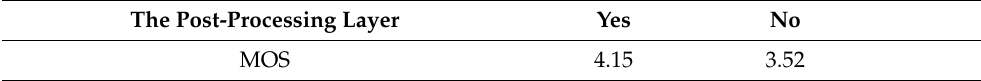
Table 9. The MOS ablation experiment for a post-processing layer.